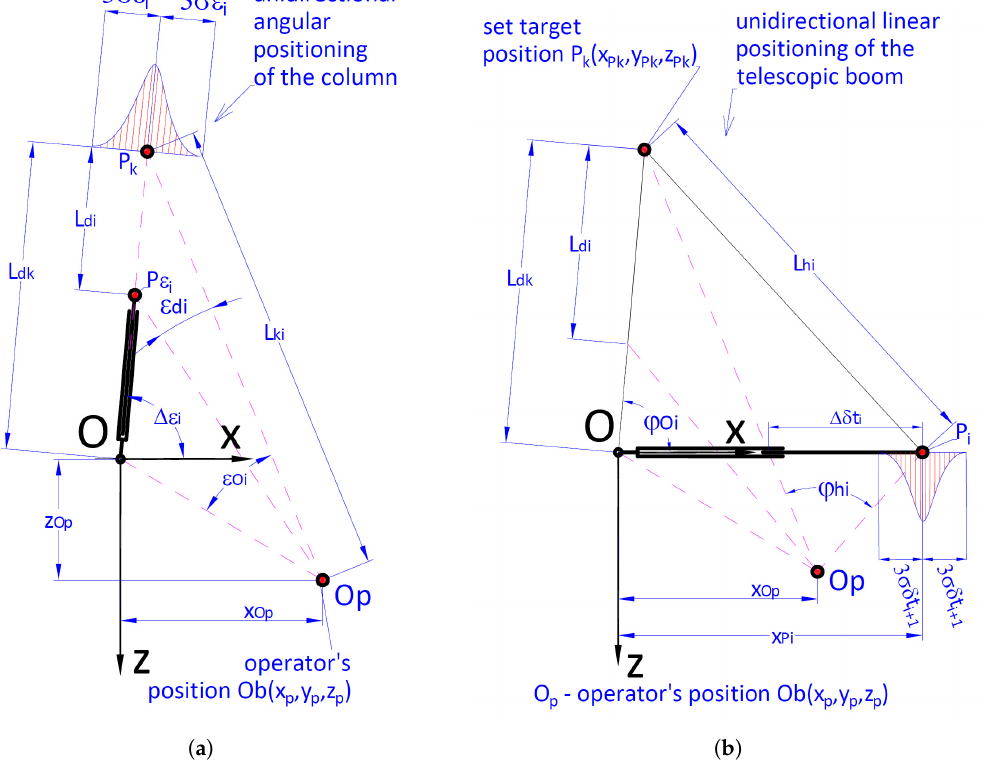
Figure 6. Parametrical sketch for determining the accuracy of unidirectional positioning of the cargo handling crane depending on an operator’s position Op ( x Op , z Op ). ( a ) unidirectional angular positioning of the crane column. ( b ) unidirectional linear positioning of a telescopic